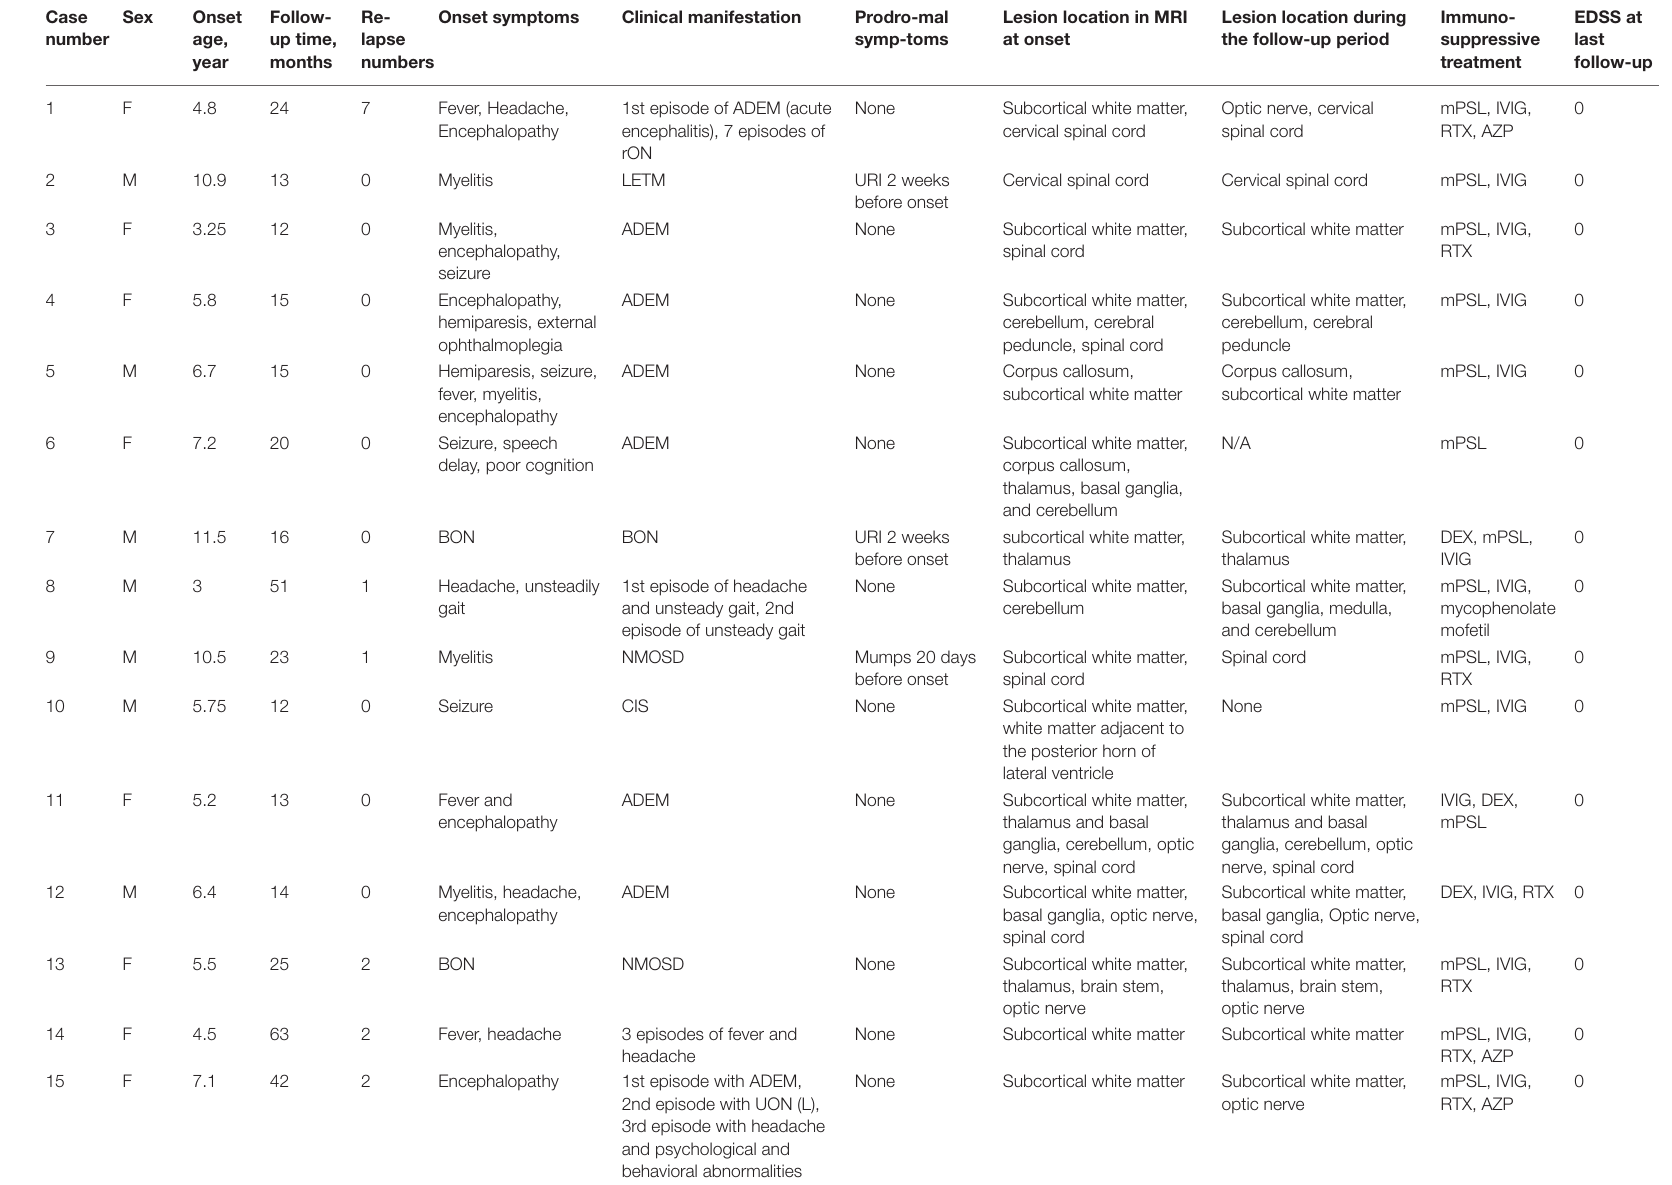
TABLE 1 | The demographic and clinical